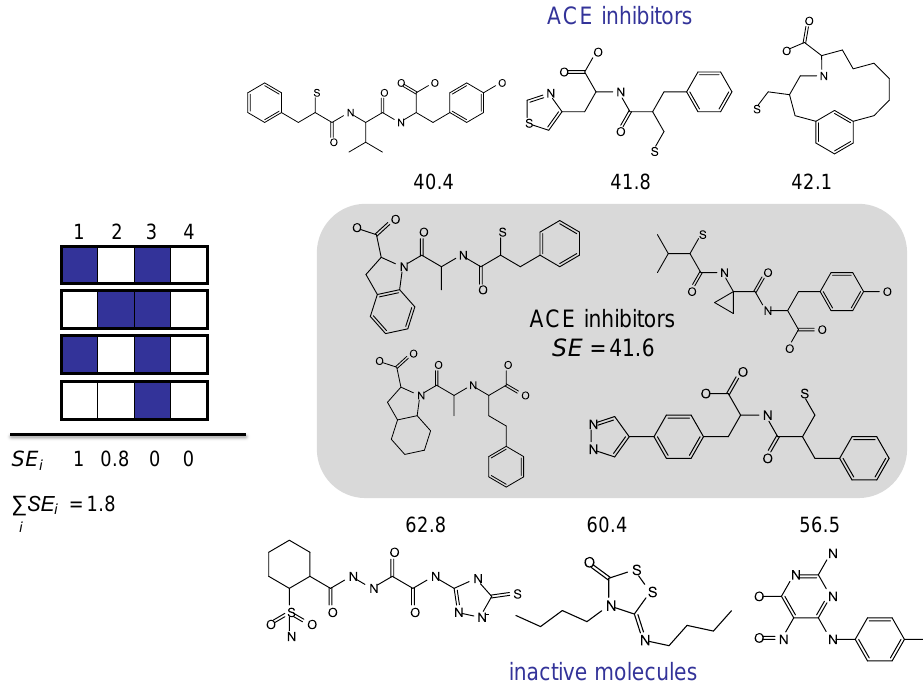
Figure 5. Shannon entropy-based fingerprint similarity. The fingerprint Shannon entropy score (SE) is calculated as the sum of the Shannon entropies of individual bit positions (left). The SE of a reference set of four acetylcholine esterase (ACE) inhibitors is shown on the right. The SE is recalculated when individual test compounds are added to the set. For active compounds, the SE value changes only very little (top three compounds), but for inactive compounds, the SE increases notably (bottom three